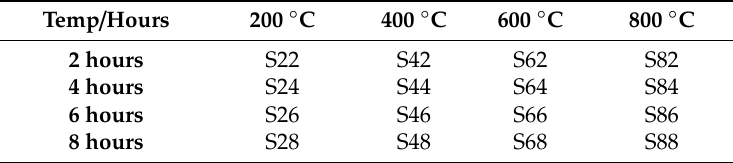
Table 3. Mix designation for heat-treated